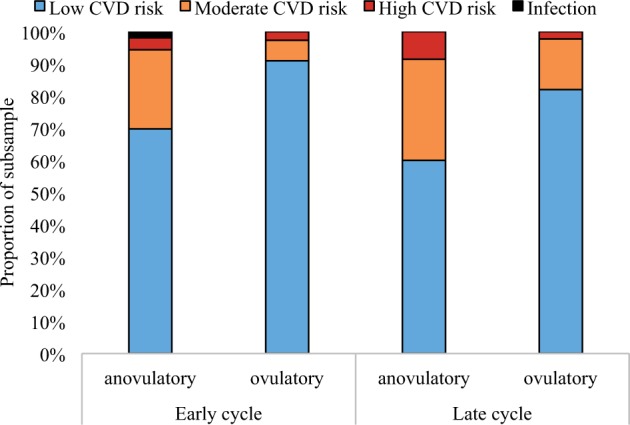
Cardiovascular (CVD) risk category (according to AHA guidelines) differs by cycle phase (early cycle: before Day 14; late cycle: after Day 14) and ovulation status